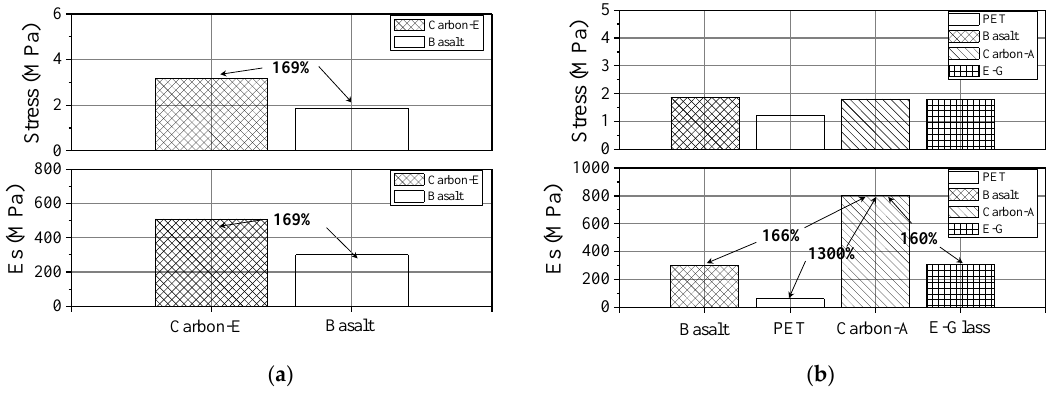
Figure 9. Analysis of pull-out specimens: ( a ) type of textile; ( b ) type of weaving.